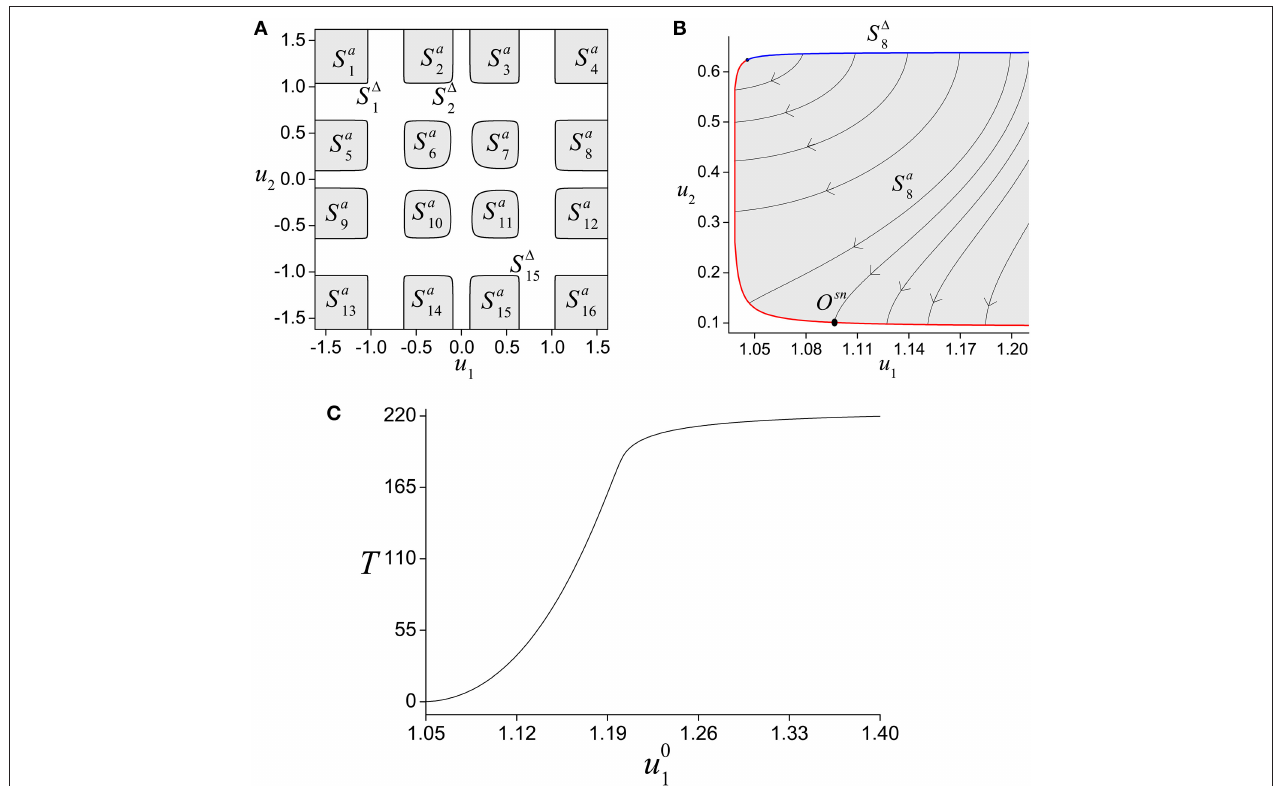
FIGURE 5 | (A) Mutual location of the stable slow submanifolds ( S a j ) of system (5) on the phase plane ( u 1 , u 2 ). The boundaries of stable submanifolds ( S ∆ j ) defined by the equations 1 = 0. (B) Trajectories behavior on slow submanifold S a 8 . (C) Dependence of motion time over submanifold S a 8 to its boundary S ∆ 8 on the initial conditions. Parameter values: a = 0.32, b = 0.79, c = 1.166, and d =